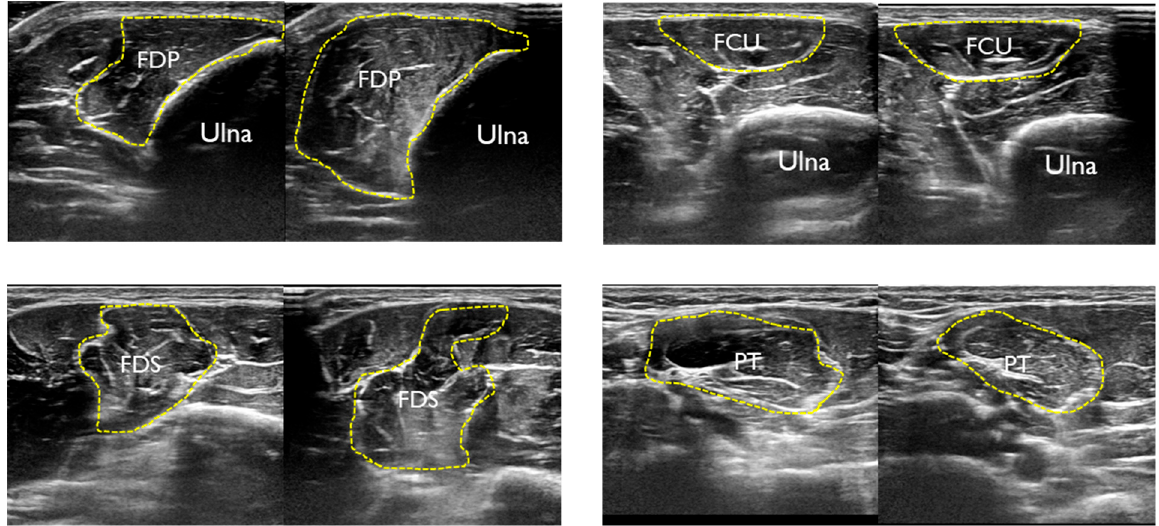
Figure 3. US images of each the flexor pronator muscles at rest and during contraction.